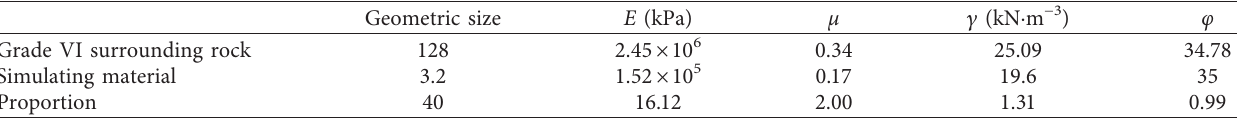
Figure 8: Synthetic experiment system of the tunnel and surrounding rock. Test 1: we cast the surrounding rock proportionately and simulated the cross rock beam +heading method. Test 2: based on the test 1, we excavated the secondary cross tunnel from the side, adopting the win-side heading method after the excavation and support of the main tunnel. Table 5: Principal stress of key points